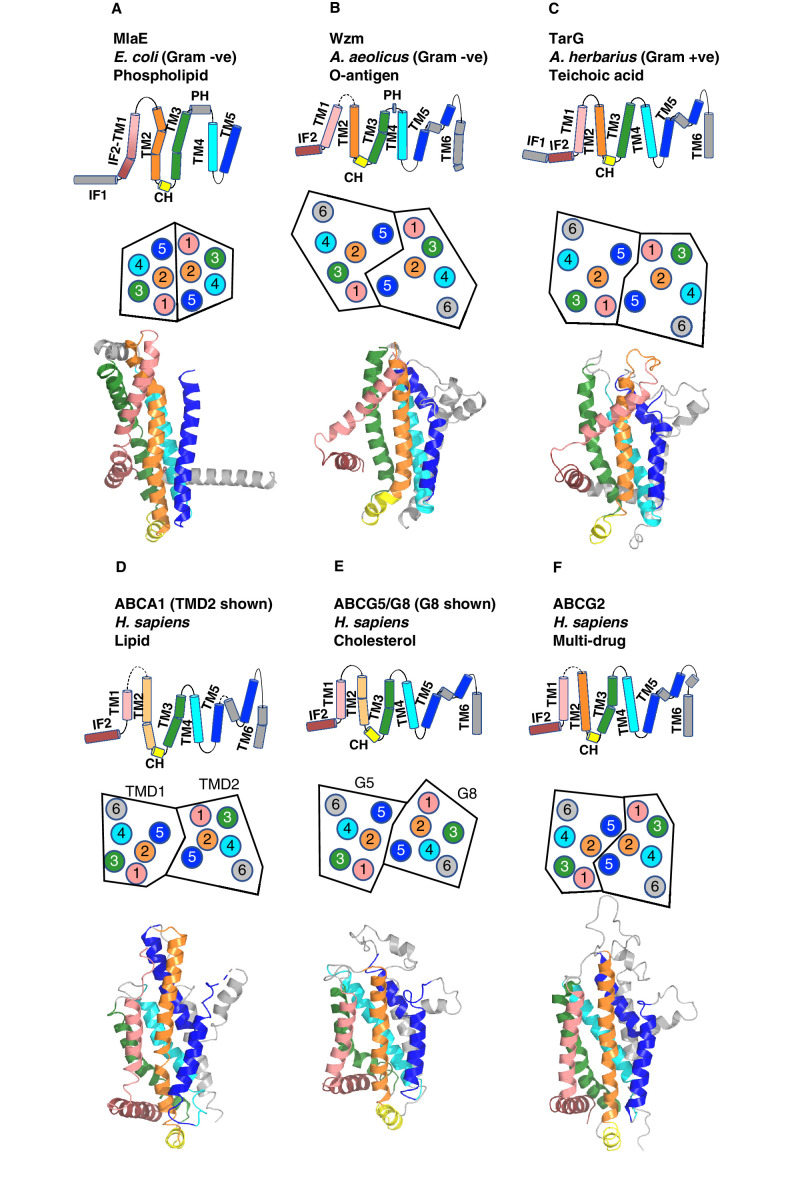
Comparison of MlaE to other ABC transporters.(A) MlaE, this paper, PDB 6XBD; (B) O-antigen transporter, PDB 6OIH; (C) TarG, PDB 6JBH; (D) ABCA1, PDB 5XJY, TMD2 shown; (E) ABCG5/G8, PDB 5DO7, G8 shown; (F) ABCG2, PDB 6HBU. Topology diagrams (first row); schematics representing helices at the dimer interface, viewed from the periplasm (each circle represents a helix) (second row); and cartoon views of monomers (third row) are shown.